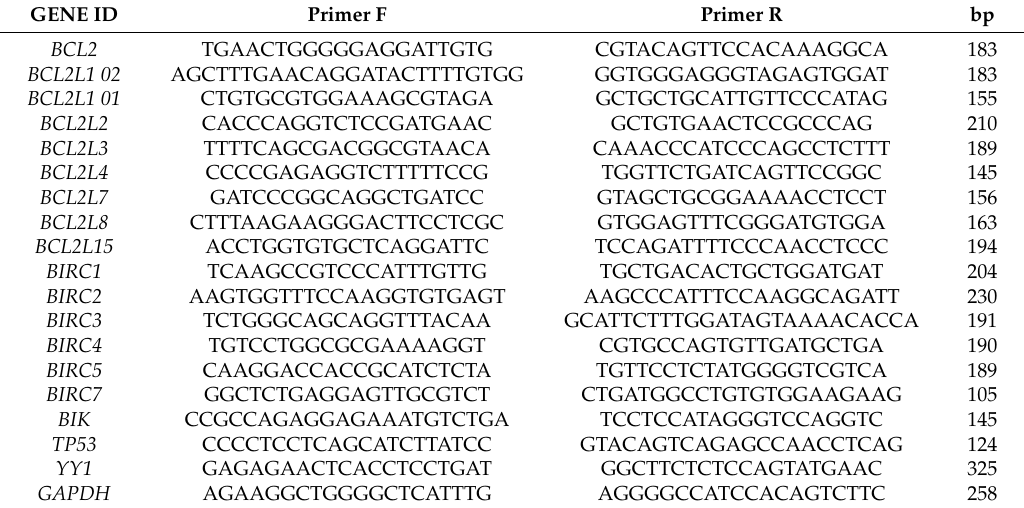
Table 4. Primers used for RT-PCR analyses of genes regulators within the apoptotic